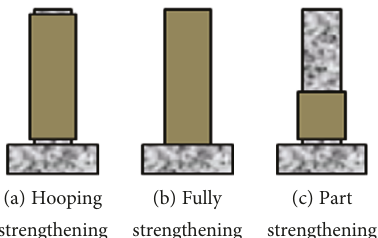
Figure 1: Concrete columns strengthened with circular steel